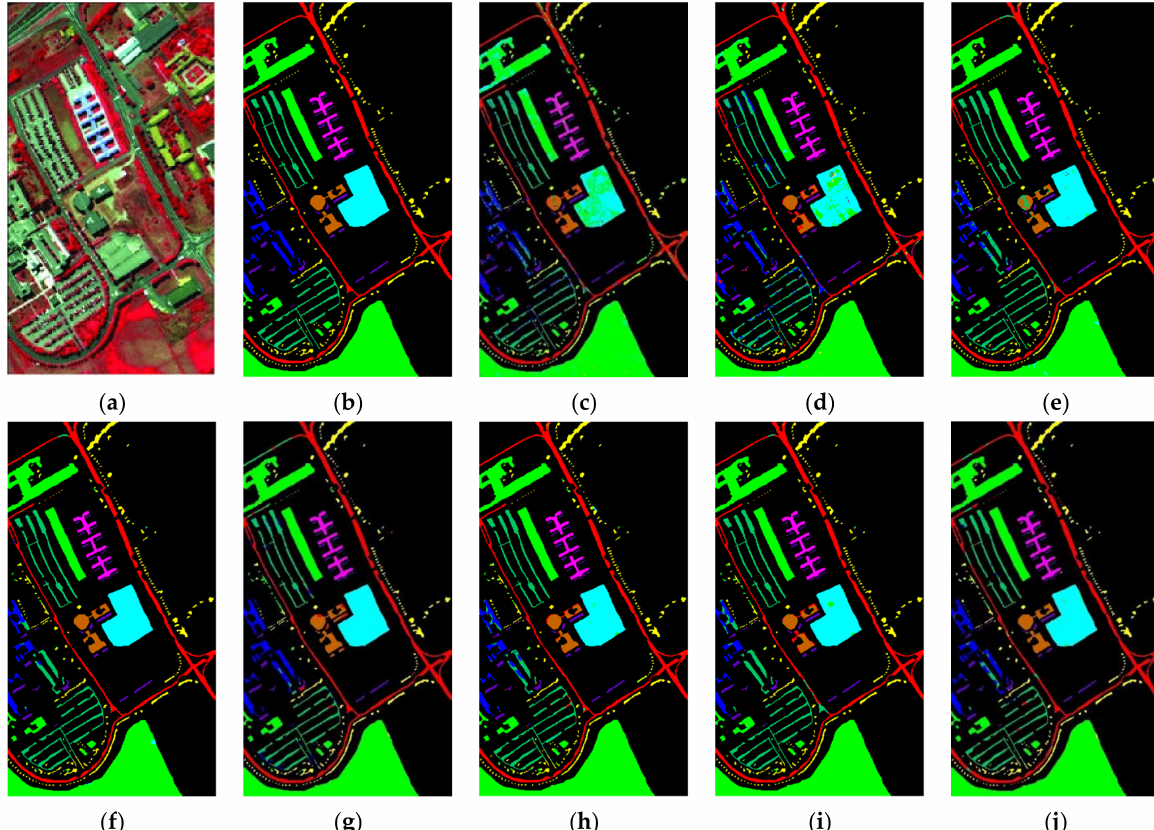
Figure 6. Classification maps for PU dataset using 1% training samples. ( a ) False-color image; ( b ) ground truth; ( c ) SVM (OA: 84.71%); ( d ) CDCNN (OA: 91.88%); ( e ) SSRN (OA: 97.12%); ( f ) FDSSC (OA: 97.19%); ( g ) HybridSN (OA: 96.38%); ( h ) DBMA (OA: 96.85%); ( i ) DBDA (OA: 95.87%); ( j ) proposed method (OA: